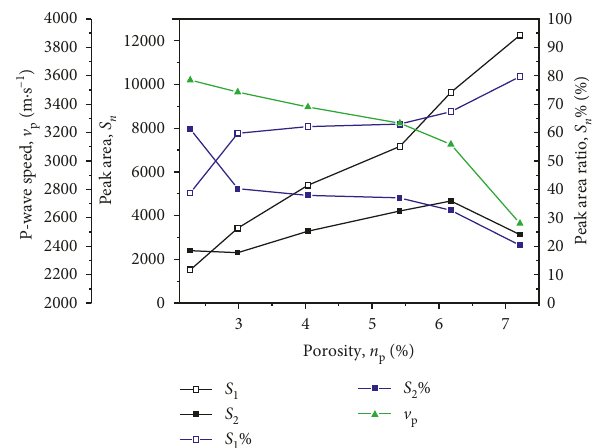
Figure 4: Relationship between n